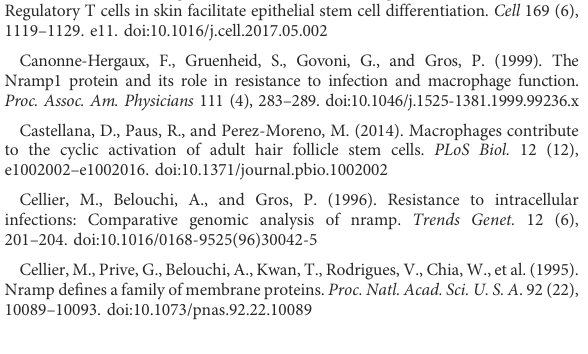
Modules were distinguished from each other by assigning different colors. SUPPLEMENTARY FIGURE S3 Network heatmap plot, all genes. SUPPLEMENTARY FIGURE S4 “ Genes of the regulatory networks target-biological process-signaling pathway ” network. SUPPLEMENTARY TABLE S1 Summary of RNA-sequencing results and quality data output. SUPPLEMENTARY TABLE S2 The positive and negative cutoff values for the control group and the melatonin-implanted group. SUPPLEMENTARY TABLE S3 Numbers of co-expression relationships in each developmental stage and GCN. SUPPLEMENTARY TABLE S4 The module-associated SNP by eGWAS analysis. SUPPLEMENTARY TABLE S5 The blast search